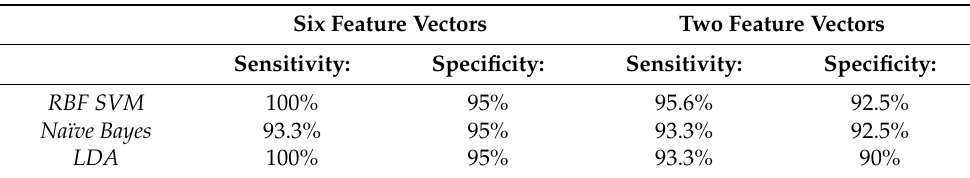
Table 2. Comparison of sensitivity and specificity of three classifiers in the case of six and two feature vectors used for classification.